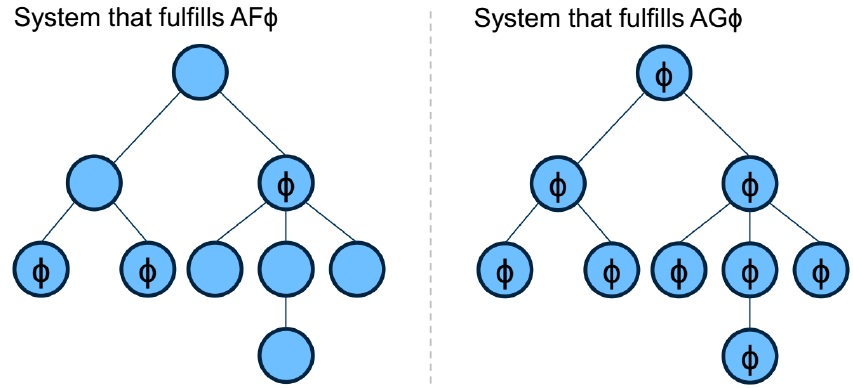
Figure 1. Computation Tree Logic (CTL):